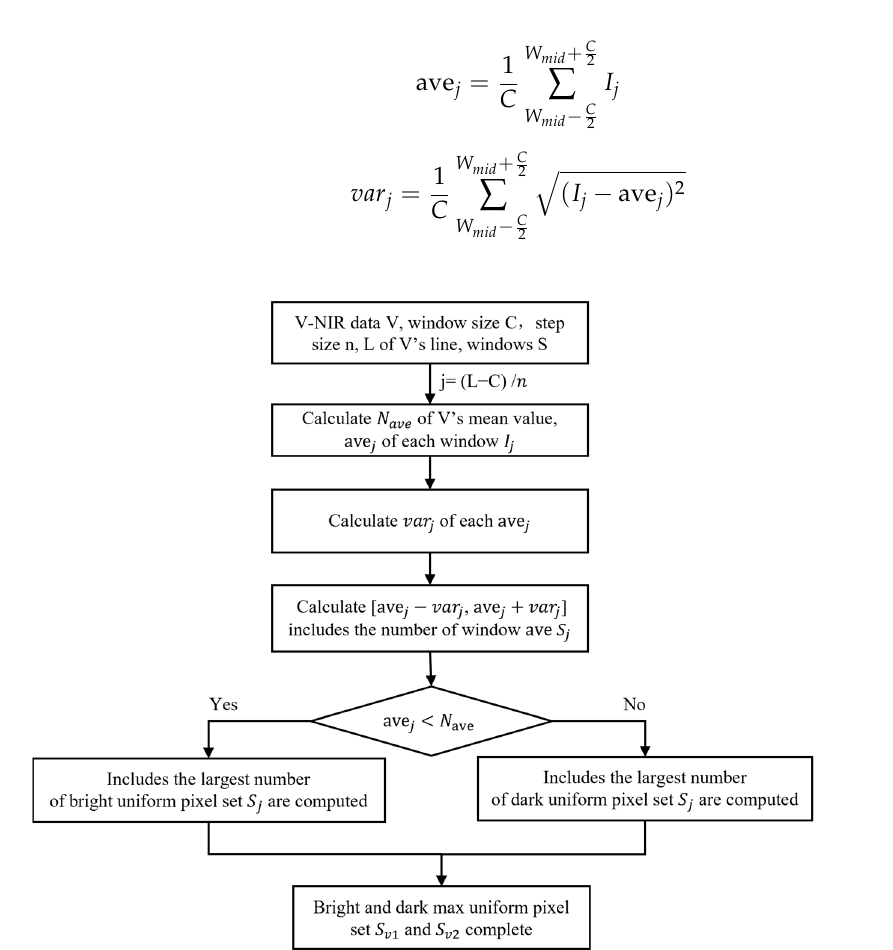
Figure 6. Flow chart of the proposed method. 𝑆 (cid:3049)(cid:2869) and 𝑆 (cid:3049)(cid:2870) denote the set of the most uniform image windows, 𝐼 (cid:3037) , that satisfy the